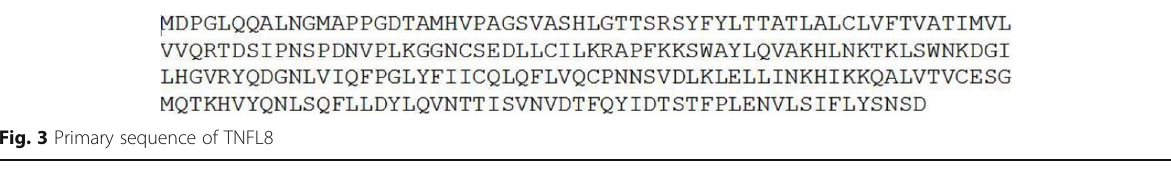
Fig. 3 Primary sequence of